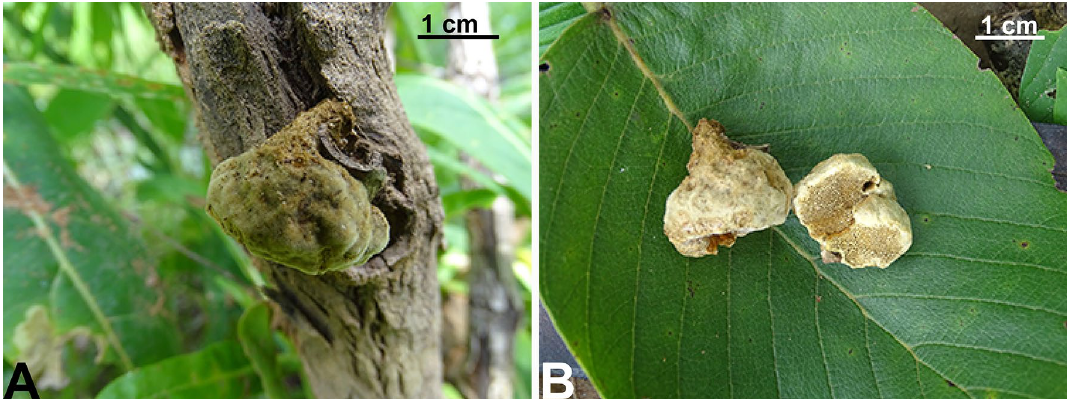
Figure 7. Field photos of Phylloporia littoralis (OAB0204). ( A ) Basidioma attached to a branch of…, ( B ) Pileus surface and